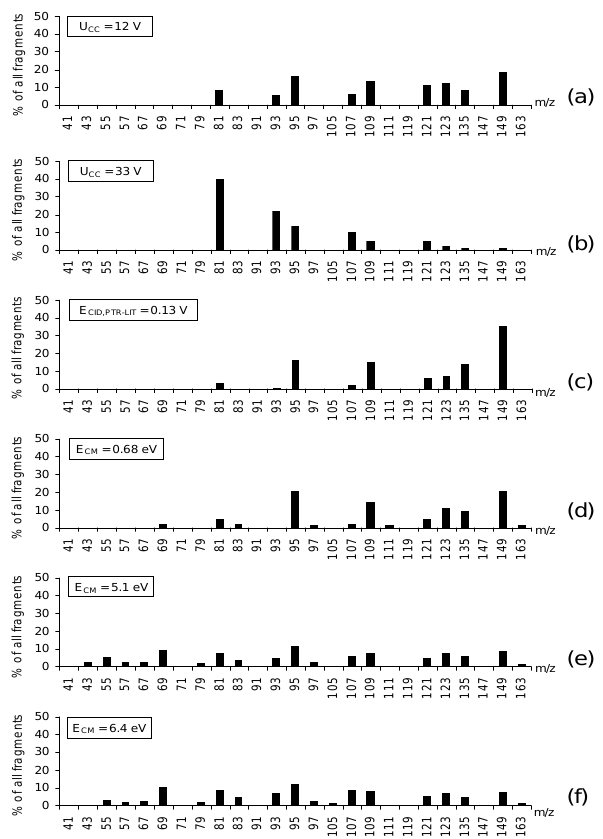
Fig. 4. Fragmentation patterns of protonated α -humulene ob- tained by (a–c) M¨uller et al. (2009) (QqQ-MS and PTR-LIT) and by (d–f) FA-TMS at three different E CM . For FA-TMS, only fragments > 1% are shown. (a) U cc =12V, (b) U cc =33V, (c) U CID , PTR − LIT =0.13V, (d) E CM =0.68eV, (e) E CM =5.1eV, and (f) E CM =6.4eV. The contribution of the precursor ion I p in the fragmentation spectra, i.e. I p / (I p + 6I fi ) , equals 95.1, 30.3 and 29.9% in graphs (d) , (e) and (f) , respectively.